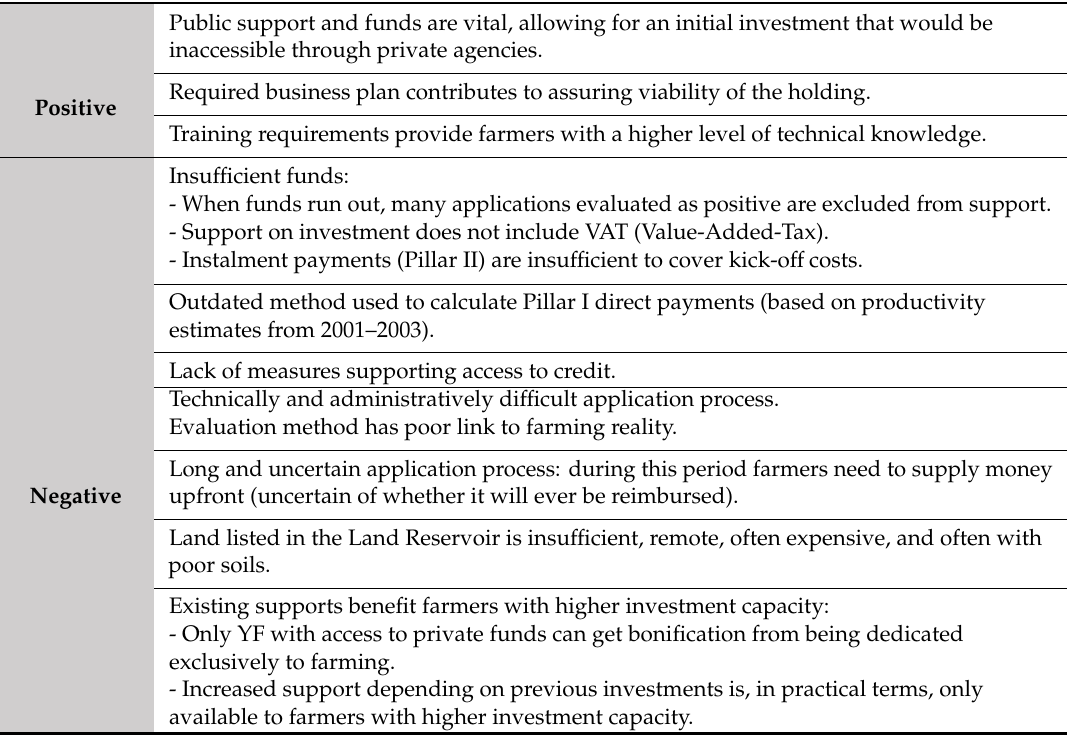
Table 2. Focus group assessment of existing young farmer support